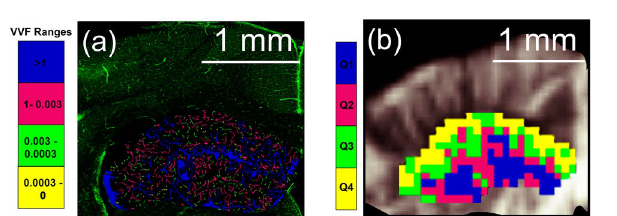
Figure 4. Mean quartile values and VVF for 5- vs. 21-month-old mice. ( a ) Comparison with age of the quartile values obtained by µ Doppler. CBV measured by µ Doppler showed significant higher values for all quartiles when comparing 5- and 21-month-old mice. 5-month-old vs 21-month-old: [Q1]: p = 0.0019, t = 3.537, df = 22; [Q2]: p = 0.0008, t = 3.872, df = 22; [Q3]: p = 0.0005, t = 4.047, df = 22; [Q4]: p = 0.0020, t = 3.504, df = 22. ( b ) Comparison with age of the mean VVF values obtained by SLCM. The VVF values determined by IB4 probing, tile-scan imaging and 3D Counter FIJI plugin, showed significant differences between 5- and 21-month-old mice. 5-month-old vs 21-month-old: [> 1]: p = 0.0023, U = 19,535; [0.003–1], [0.0003–0.003], [0–0.0003]: p < 0.0001, U = 210,691. **p < 0.0021, ***p < 0.0002, ****p < 0.0001.